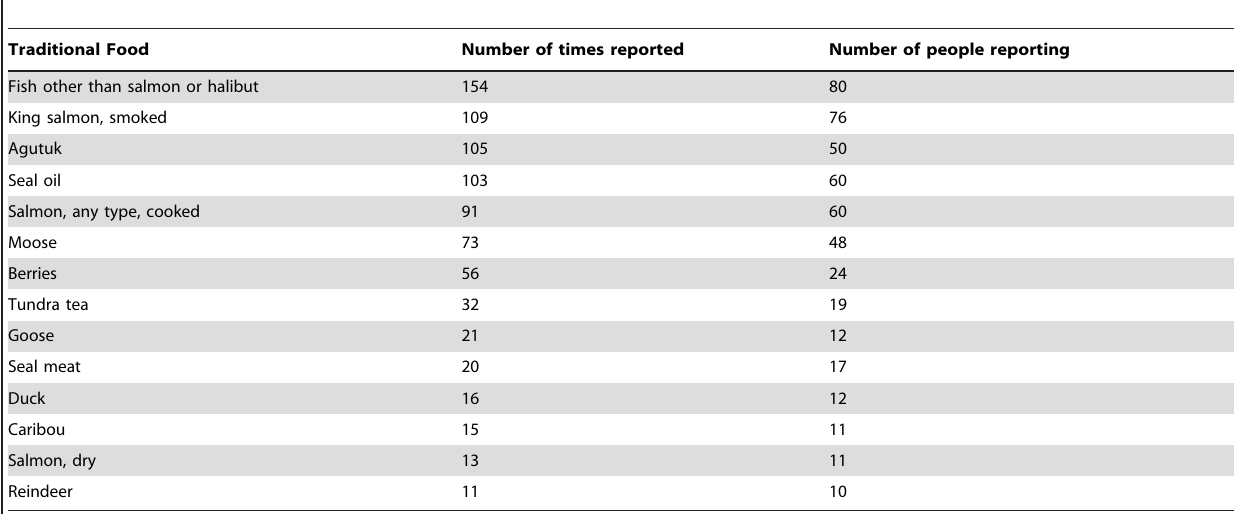
white bread and rice. Table 2 lists traditional foods most frequently reported. Fish was the most common traditional food consumed (over 40%). Table 2. Traditional foods most commonly reported on 400, 24-hour recalls among Alaska Native people (n=177).